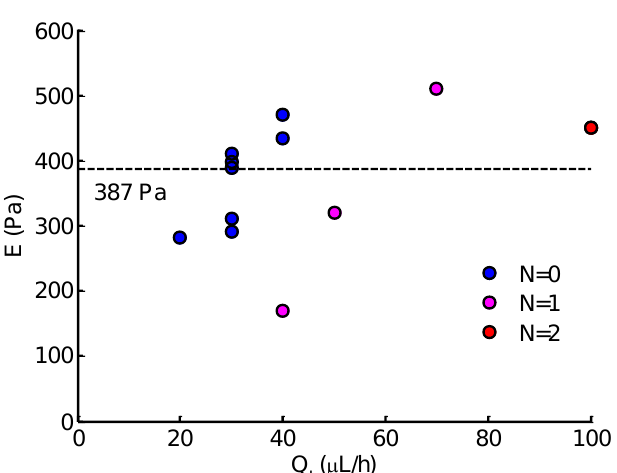
Figure 9. Young’s modulus of Hela cells calculated at different Q t . N denotes the number of open micropipette aspiration